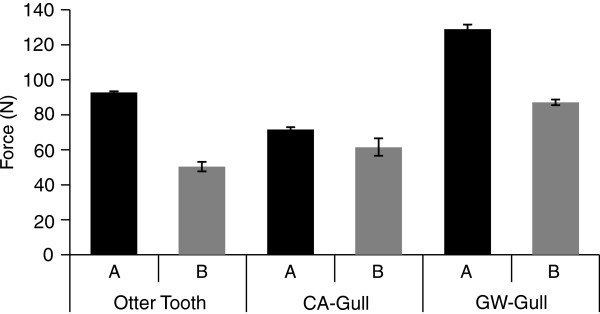
Force in Newtons (N) required for a sea otter canine tooth (otter tooth) and California gull (CA-Gull) or Glaucous-winged gull (GW-Gull) beak, to penetrate new (A: black bars) and weathered (B: grey bars) PBR plastic. The plastic used was clear linear low-density polyethylene LLDPE. The weathered LLDPE was recovered from PBRs that had been exposed, floating in Moss Landing Harbor for 12 weeks. The overall mean puncture force was 78.6 N (±3.7, n = 40).